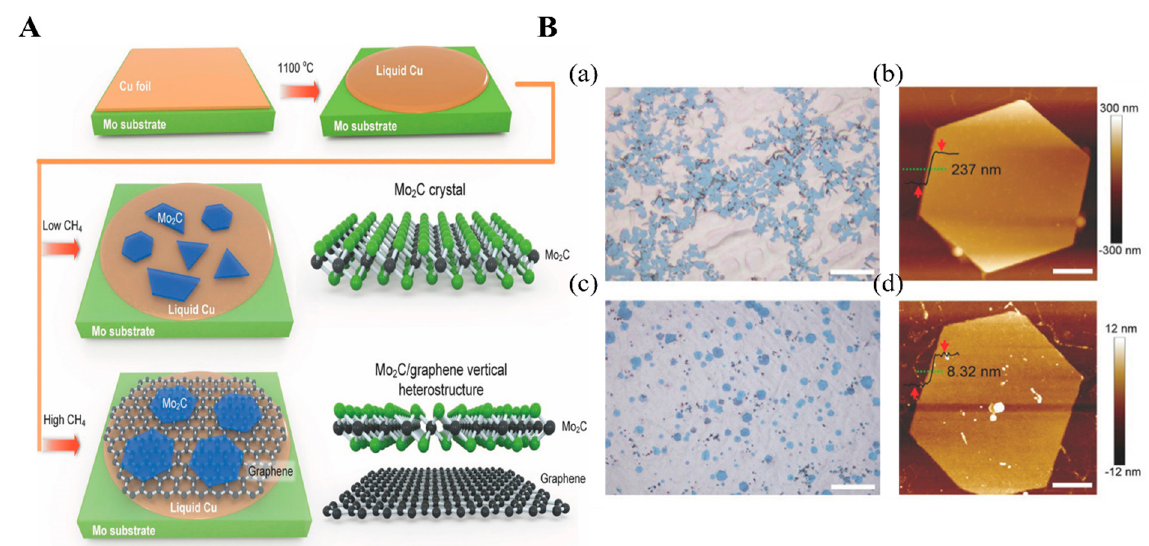
Figure 3. ( A ) Illustrative diagram for the Mo 2 C products growth under the high and low flow rates of CH 4 gas. ( B ) Surface morphology of synthesis crystals: ( a , c ) Mo 2 C crystals’ physical